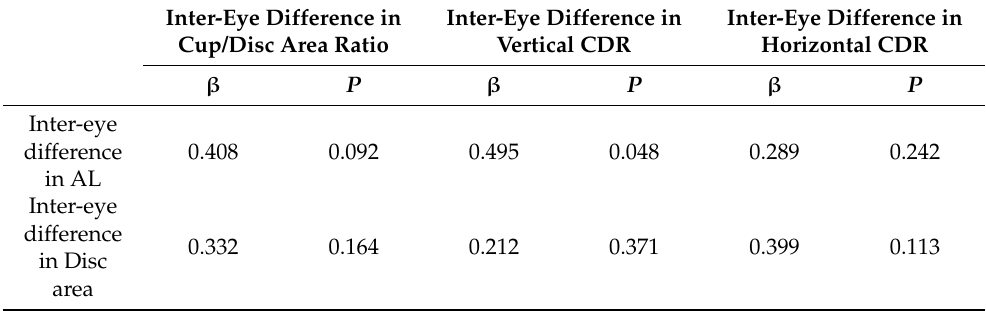
Table 5. Factors associated with inter-eye differences in cup/disc area ratio, vertical CDR, and horizontal CDR (multiple linear regression